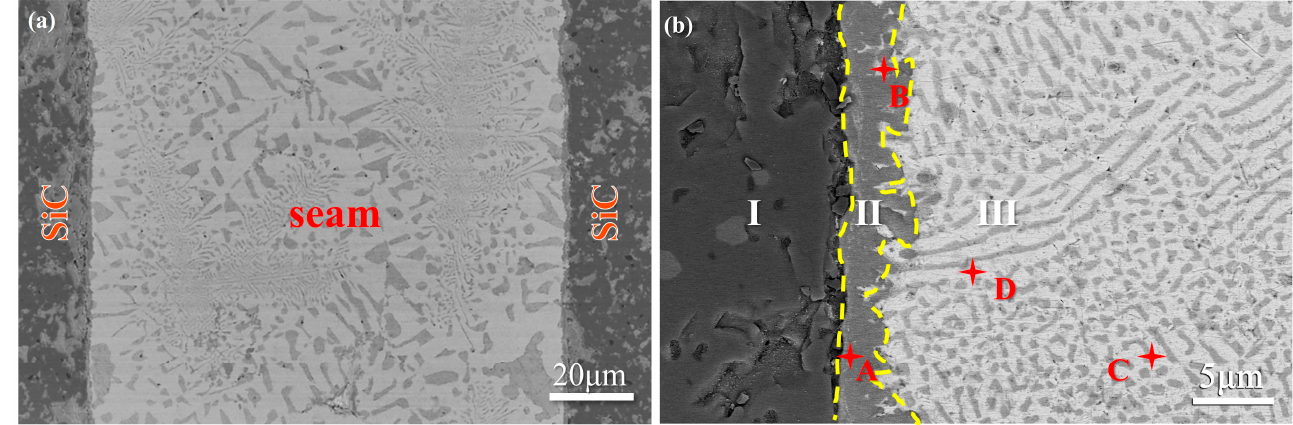
Figure 2. The SEM images of SiC joints brazed with pure AgCuTi at 900°C for 10 min ( a ) microstructure morphology of the whole brazing joint; and ( b ) local magnification of reaction layer.